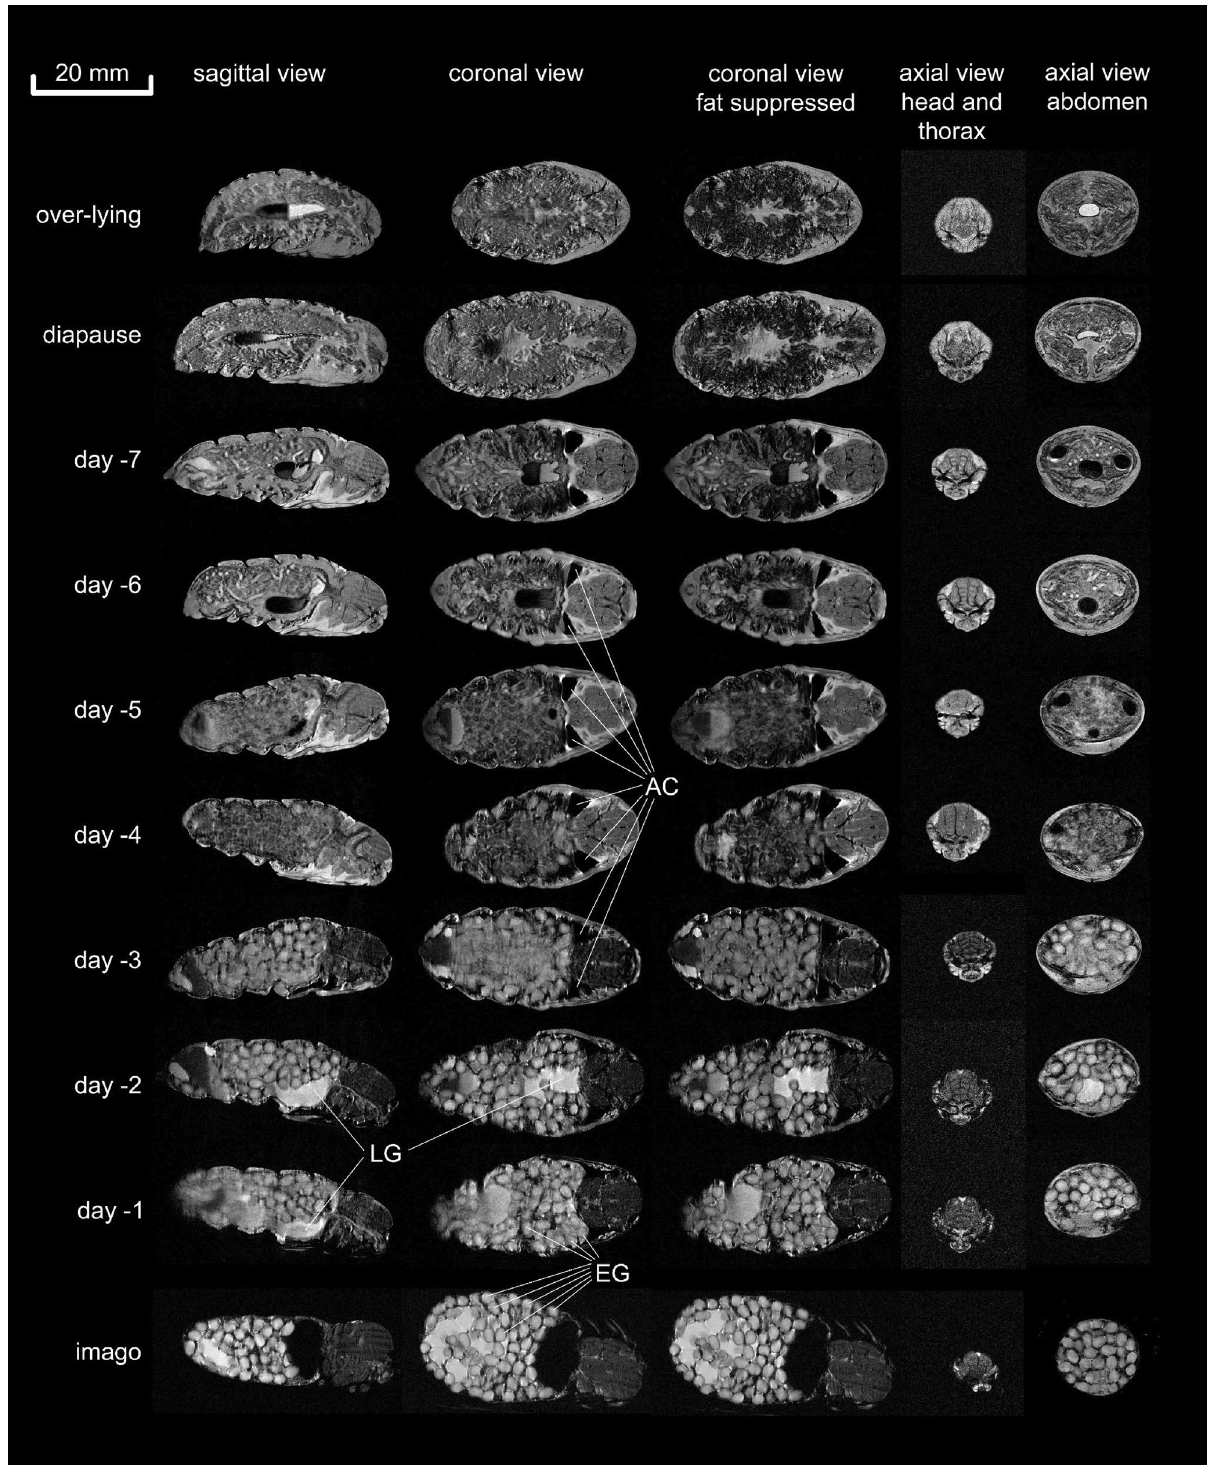
Figure 3. Development of a female pupa from diapause to imago on a day-to-day basis. While many processes were similar in female and male pupae, the most striking development in the female body was the massive production of eggs (EG) which filled the female’s abdomen almost completely. The only other prominent abdominal features are the labial glands (LG) appearing as a bright cranial-ventral object and the gut filled with water and sediment. In female imagoes, a liquid reservoir is visible close to the genital opening, most likely containing the “glue” that is needed to fix the eggs on the substrate during oviposition; AC air